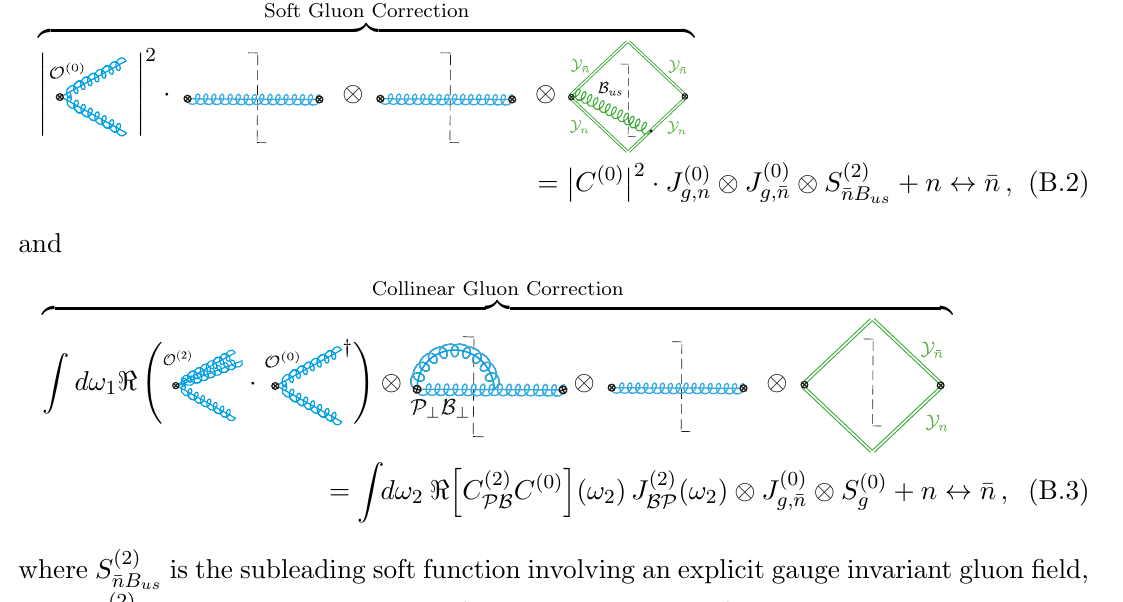
Table 2 . Leading order contributions to the decay from radiative functions. The soft quark contribution arises from two In category 1, i.e. for the gluon corrections, we have two hard scattering